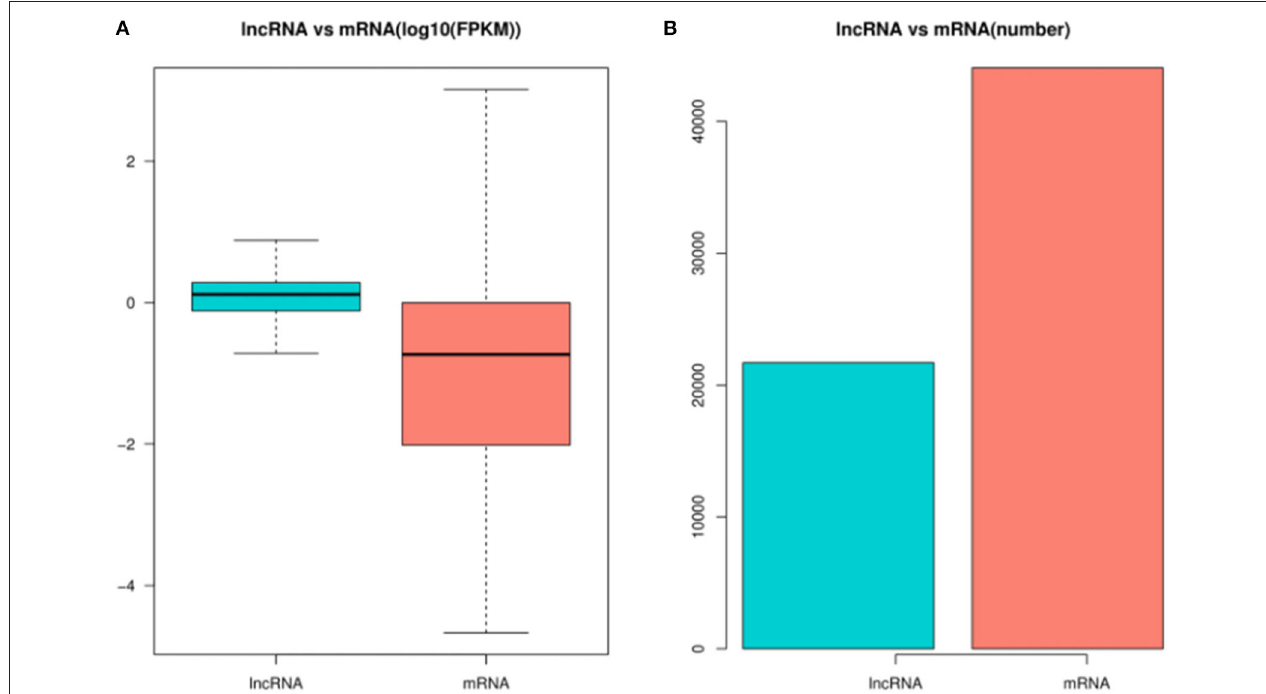
FIGURE 3 | The expression levels and amounts of lncRNAs and mRNAs. (A) Boxplots of lncRNA and mRNA expression levels (with log10 FPKM method) in the control group and treatment group. (B) The numbers of lncRNAs and mRNAs in pig ovaries in in the control group and treatment group.